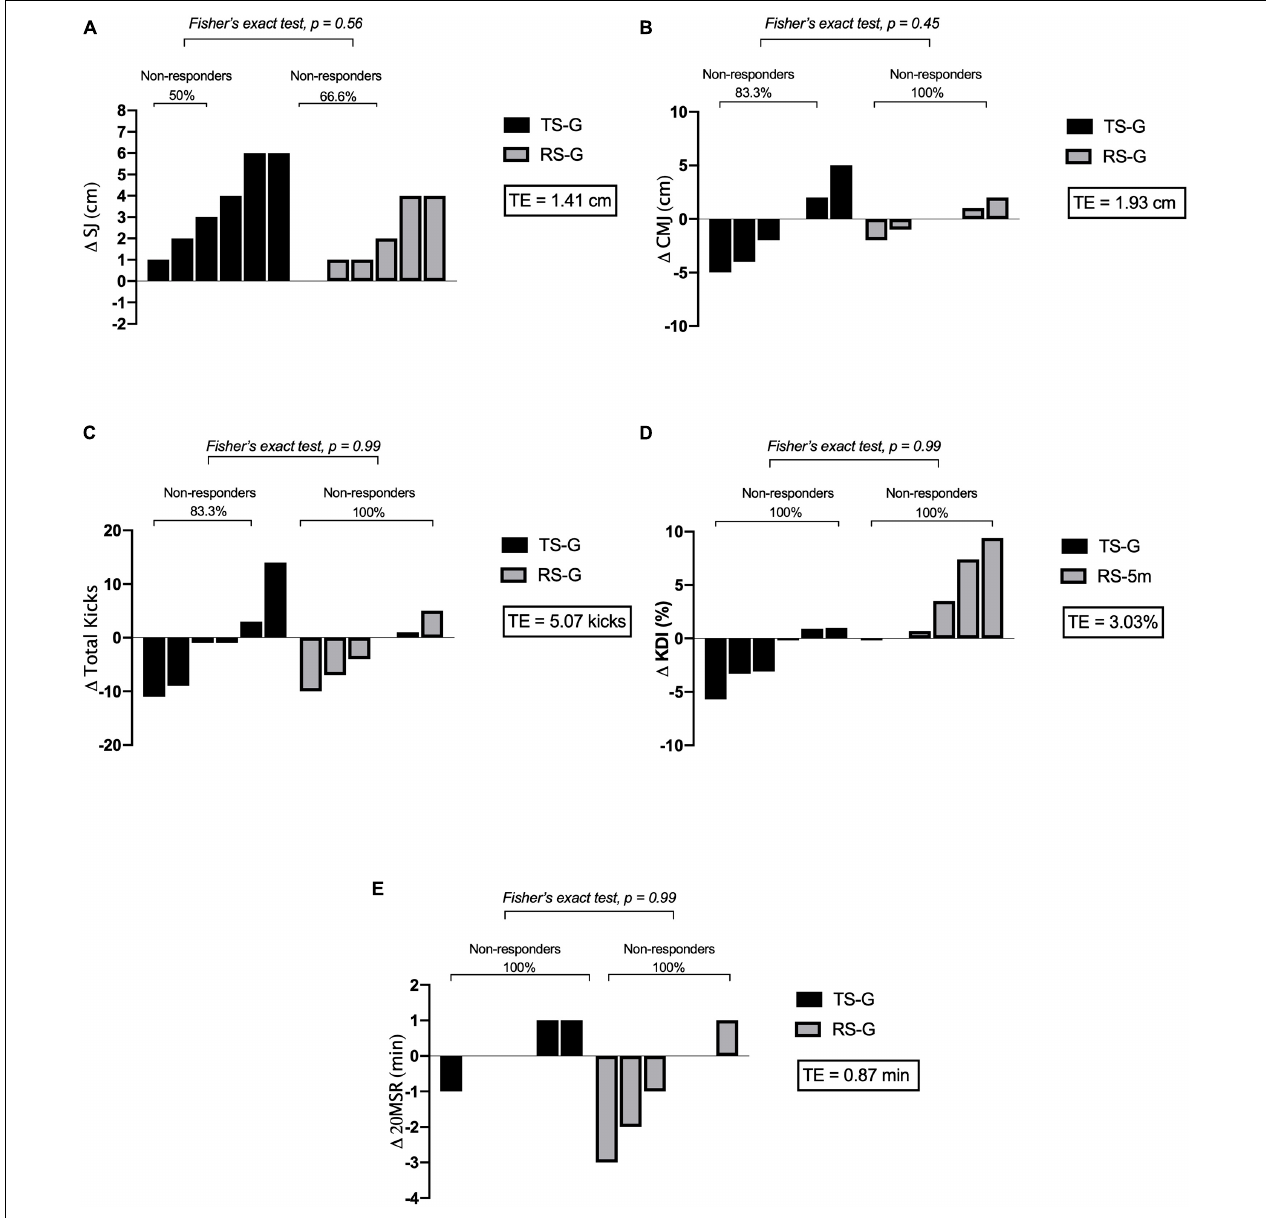
FIGURE 3 | Inter-individual variability of the response of both training groups on taekwondo-related fitness. (A) SJ, (B) CMJ, (C) FSKT MULT total kicks, (D) KDI, and (E) 20MSR. (cid:49) , post-pre changes; TS-G, technical-specific group; RS-G, repeated-sprint group; TE, technical